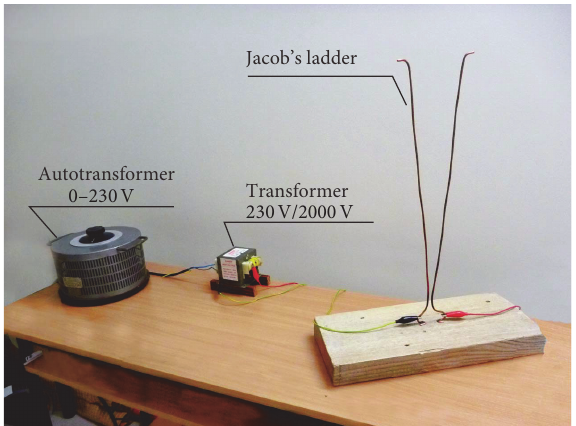
Figure 2: Picture of the measuring system depicting the object under